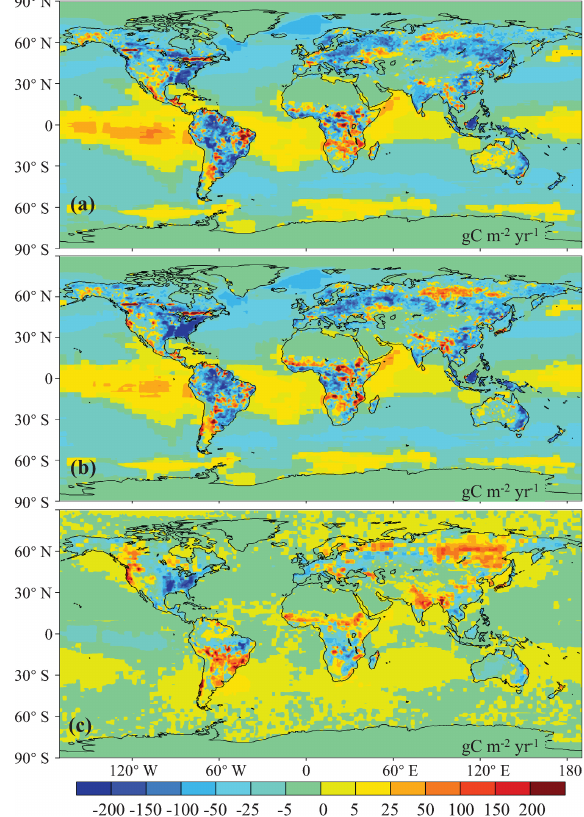
Figure 7. Distributions of the mean annual terrestrial ecosystem and ocean carbon fluxes: ( a ) prior, ( b ) posterior, and ( c ) their differences (posterior–prior) (unit: gCm − 2 yr − 1